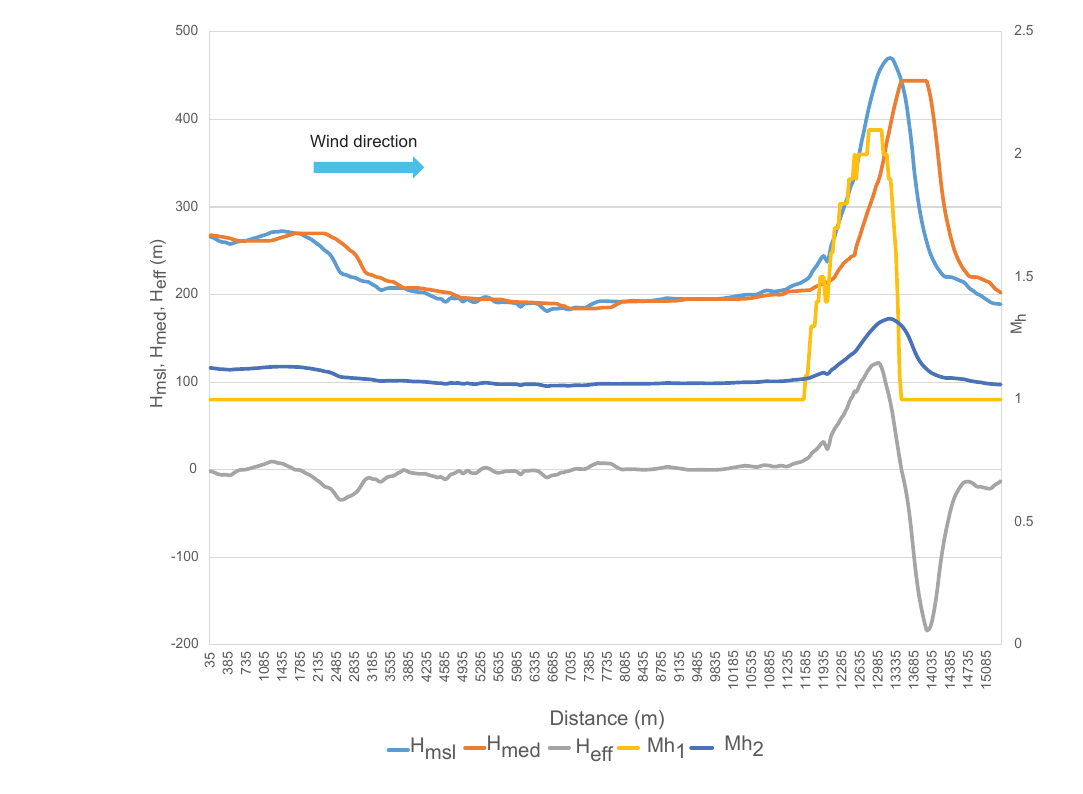
Figure 4. Variations in elevation ( H msl ), median elevation ( H med ), and the effective elevation ( H eff ) (left axis) and topographic multipliers Mh1 and Mh2 (Eq. 5, Fig. 3) (right axis) along a transection from northwest to southeast (the black line in Fig. 5) crossing the Pyhätunturi Fell in northern Finland.